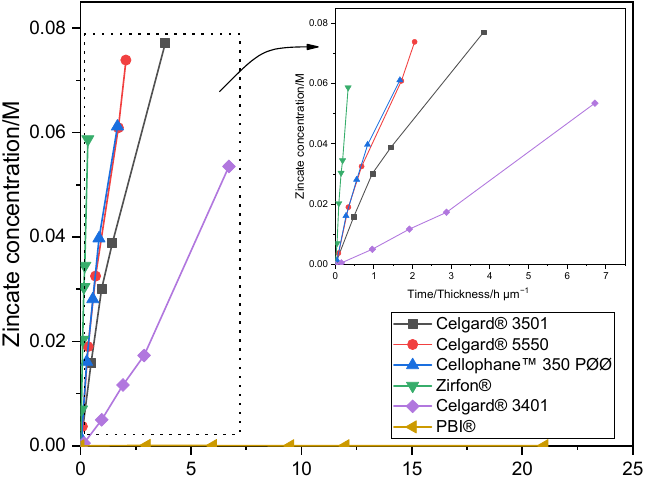
Figure 1. Zn(OH) 4 2 − crossover concentration vs. time of Celgard ® 3501, Celgard ® 3401, Celgard ® 5550, Cellophane™ 350 PØØ, and Zirfon ® and PBI ® . Lines in the figure are guides for the eye.